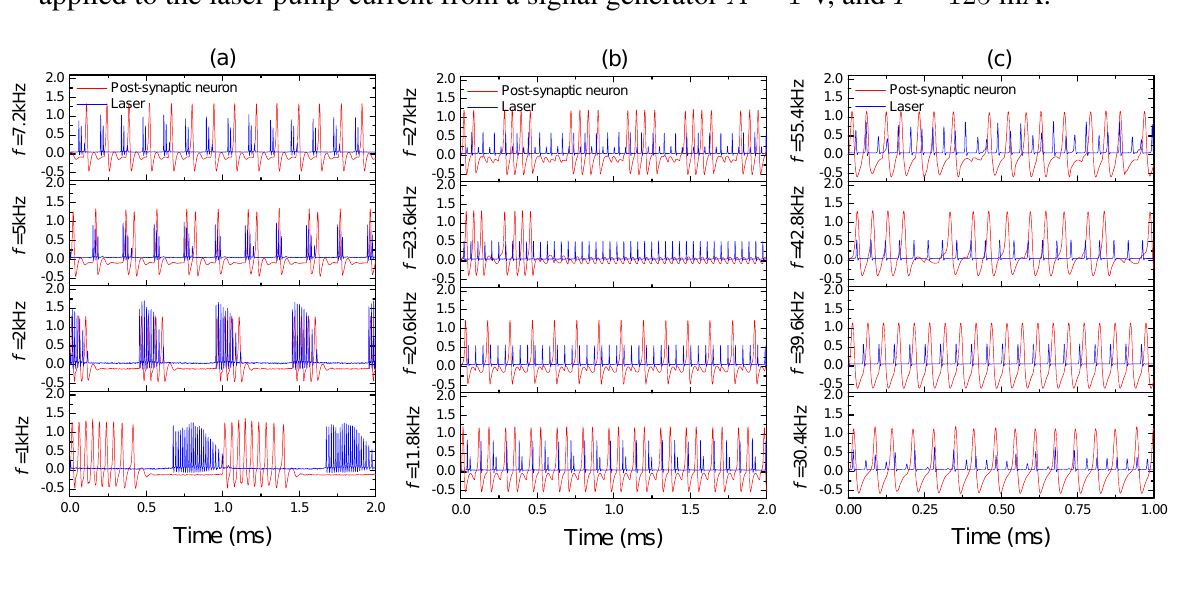
Figure 4. Laser (blue traces) and post-synaptic neuron (red traces) responses to harmonic modulation at ( a ) low, ( b ) middle and ( c ) high frequencies. The amplitude of the input signal applied to the laser pump current from a signal generator A = 1 V, and I = 125 mA.